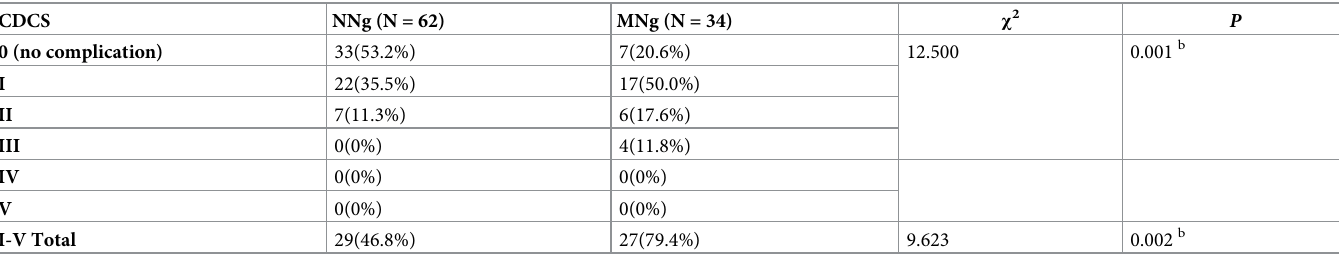
The findings showed that complication free percentage was significantly higher in NNg group compared with that of MNg group (Table 3). Incidence of grade I, II and III complica- tions were lower in NNg group compared with that of MNg group ( χ 2 = 12.500, P < 0.01). Notably, no grade IV and V complications were observed in both groups. Percentage of com- plications was significantly higher in MNg group compared with that in NNg group ( χ 2 = 9.623, P < 0.01). The average grade based on CDCS was significantly lower in NNg group (0.58 ± 0.69) compared with that in MNg group (1.21 ± 0.91) (t = 3.774, P < 0.01). Further, the 96 patients were divided into non-complication group and complication group based on occurrence of complications. ROC curve was used to determine the predictive value of GNRI for postoperative complications. The area under the curve (AUC) was 0.693 (95% CI = 0.590–0.783, Fig 1). The findings showed a GNRI cutoff value of 100.7, sensitivity of 0.763, specificity of 0.638, and highest Youden index of 0.401.